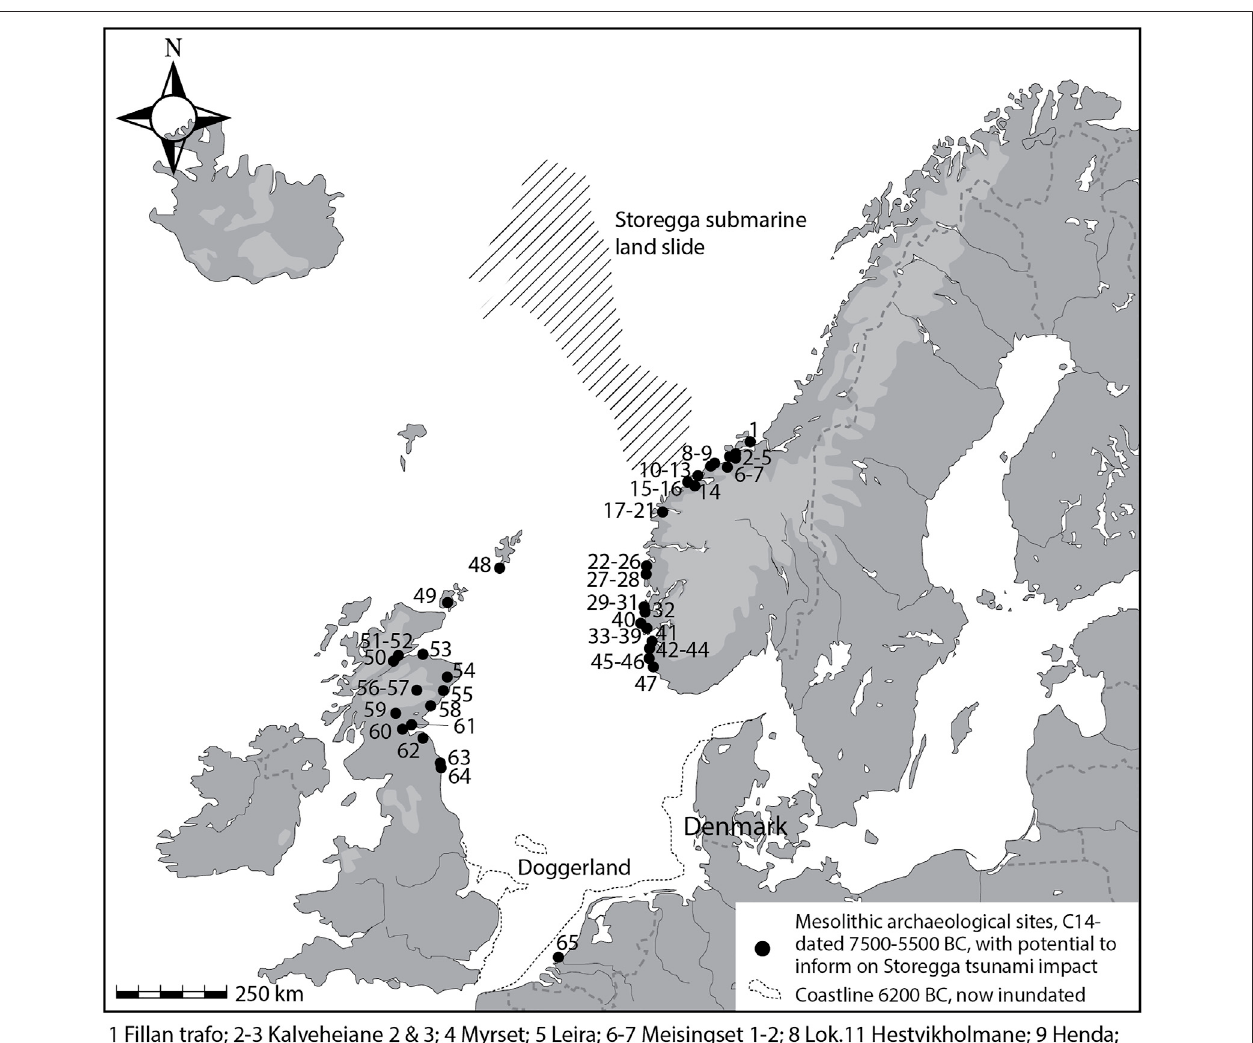
FIGURE 3 | Overview of sites that have the potential to demonstrate impact of the Storegga tsunami on a regional level. The list is not exhaustive, but it gives an overview ofprimarilycoastalMesolithicsites thatareC14datedtoaround theperiod thatthetsunami hit.Information iscompiledfrom publishedpapers,bookchapters and reports, as well as unpublished (archival) excavation reports listed in Supplementary Table S1, S2 .